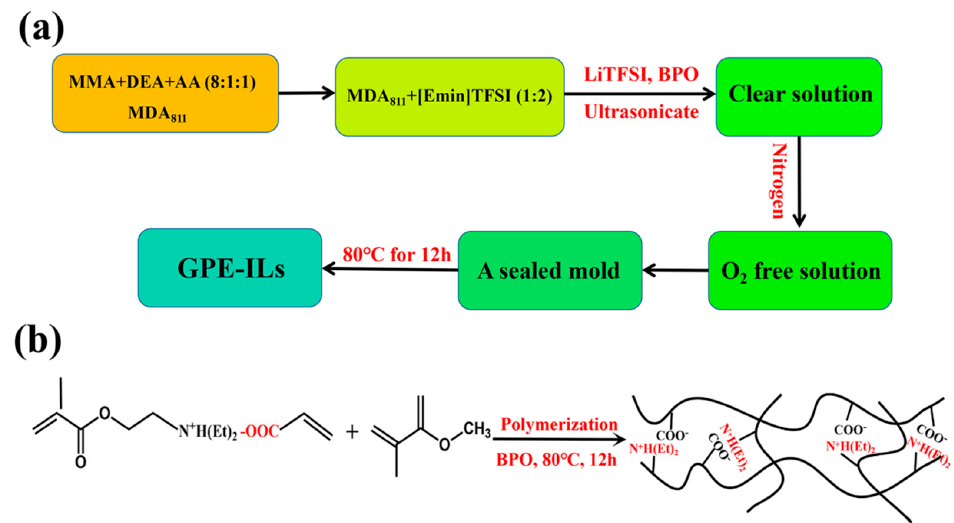
Figure 1. ( a , b ) Synthesis process of an ionic liquid-based ionically cross-linked gel polymer electrolyte (GPE-ILs).